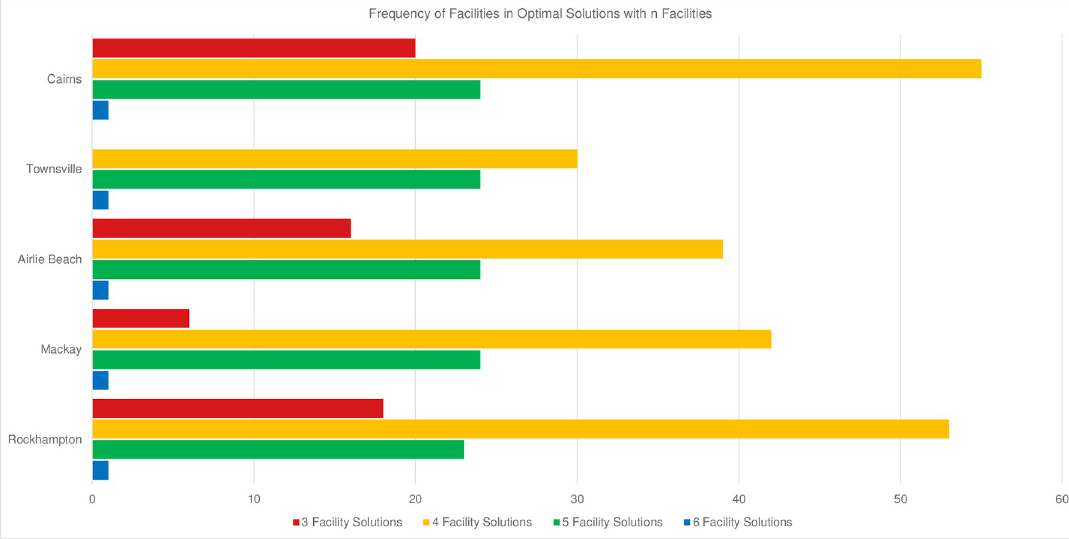
Fig 5. Frequency of potential facility locations included in optimal solutions for 100 random subsets of 50 clustered reefs. Bars are grouped by facility location and coloured by the number of optimal facilities. This plot excludes Bundaberg and Gladstone which appear in less than 5% of optimal